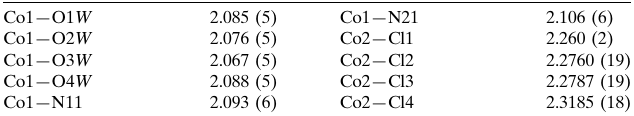
Selected bond lengths (A˚ ).